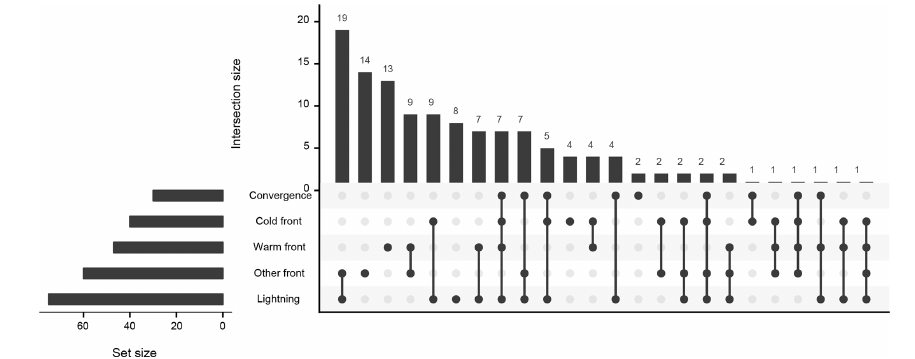
Figure 2. Frequency of weather events and their combinations during the 127d considered. Data visualized using the UpSetR R package (Conway et al.,